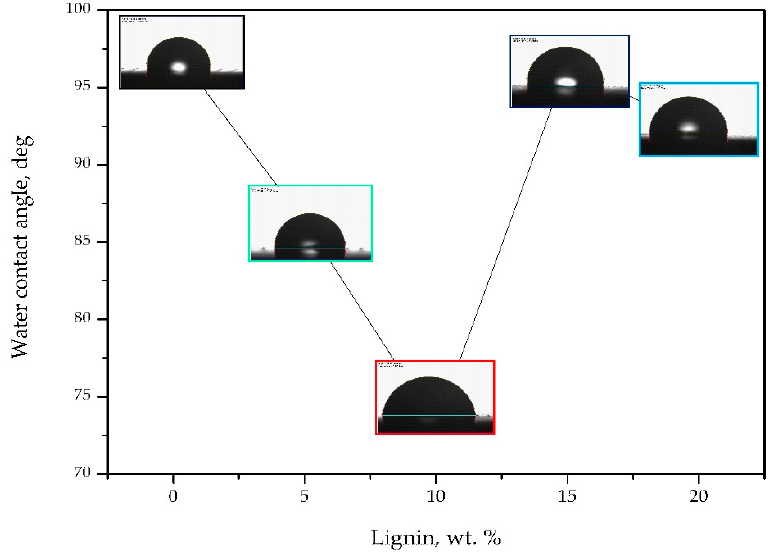
Figure 9. Water contact angle vs. lignin wt% .